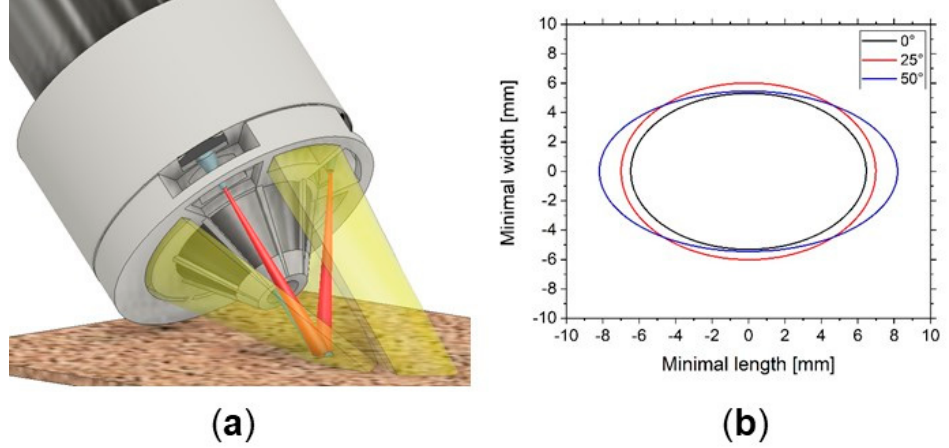
Figure 13. ( a ) Combined concept for sensors and illumination (with switched on LEDs); effective area with elliptical fit based on ( b ) minimal measured length and width.